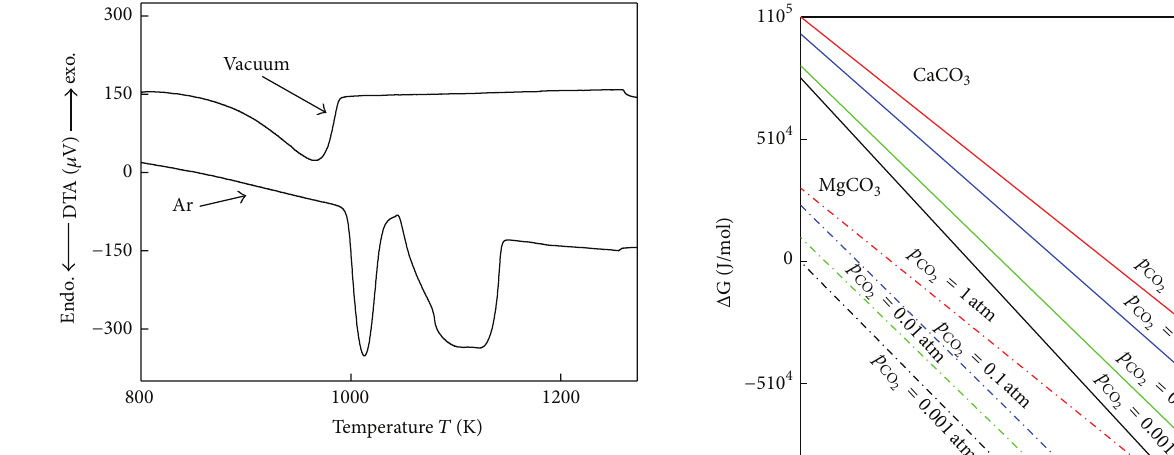
Figure 3: DTA curves of dolomite decomposition in an Ar atmo- sphere and vacuum.